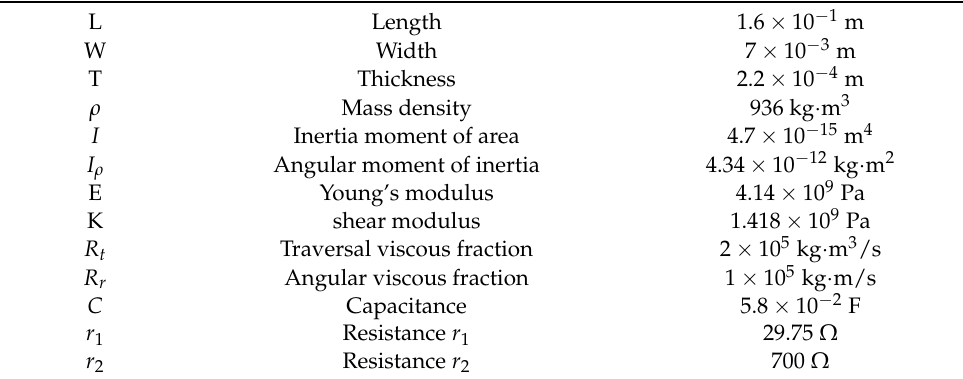
Figure 4. Experimental setup. Table 1. Numerical values of the